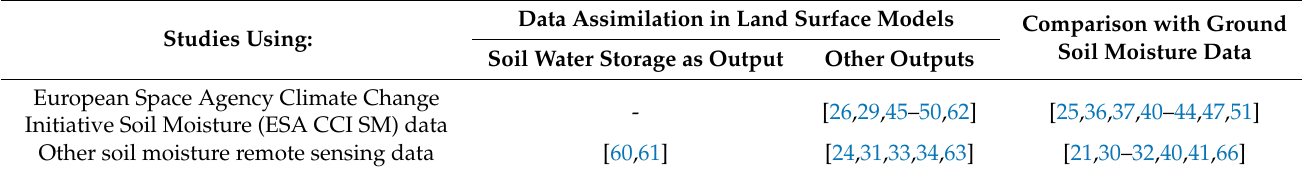
Table 1. Summary of relevant literature using satellite-derived soil moisture products. Studies